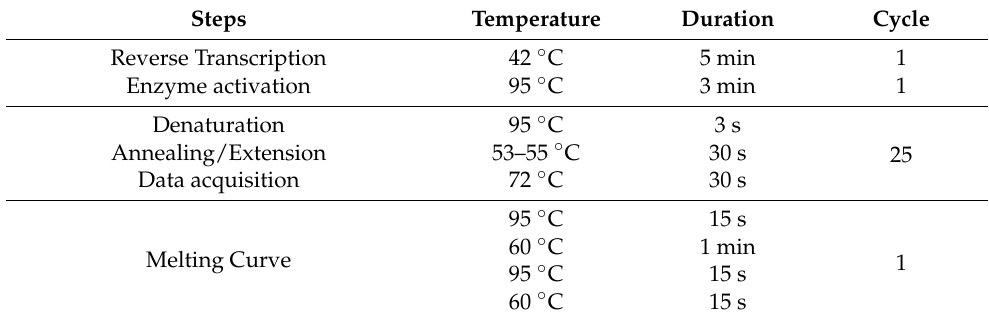
Table 3. qPCR conditions.